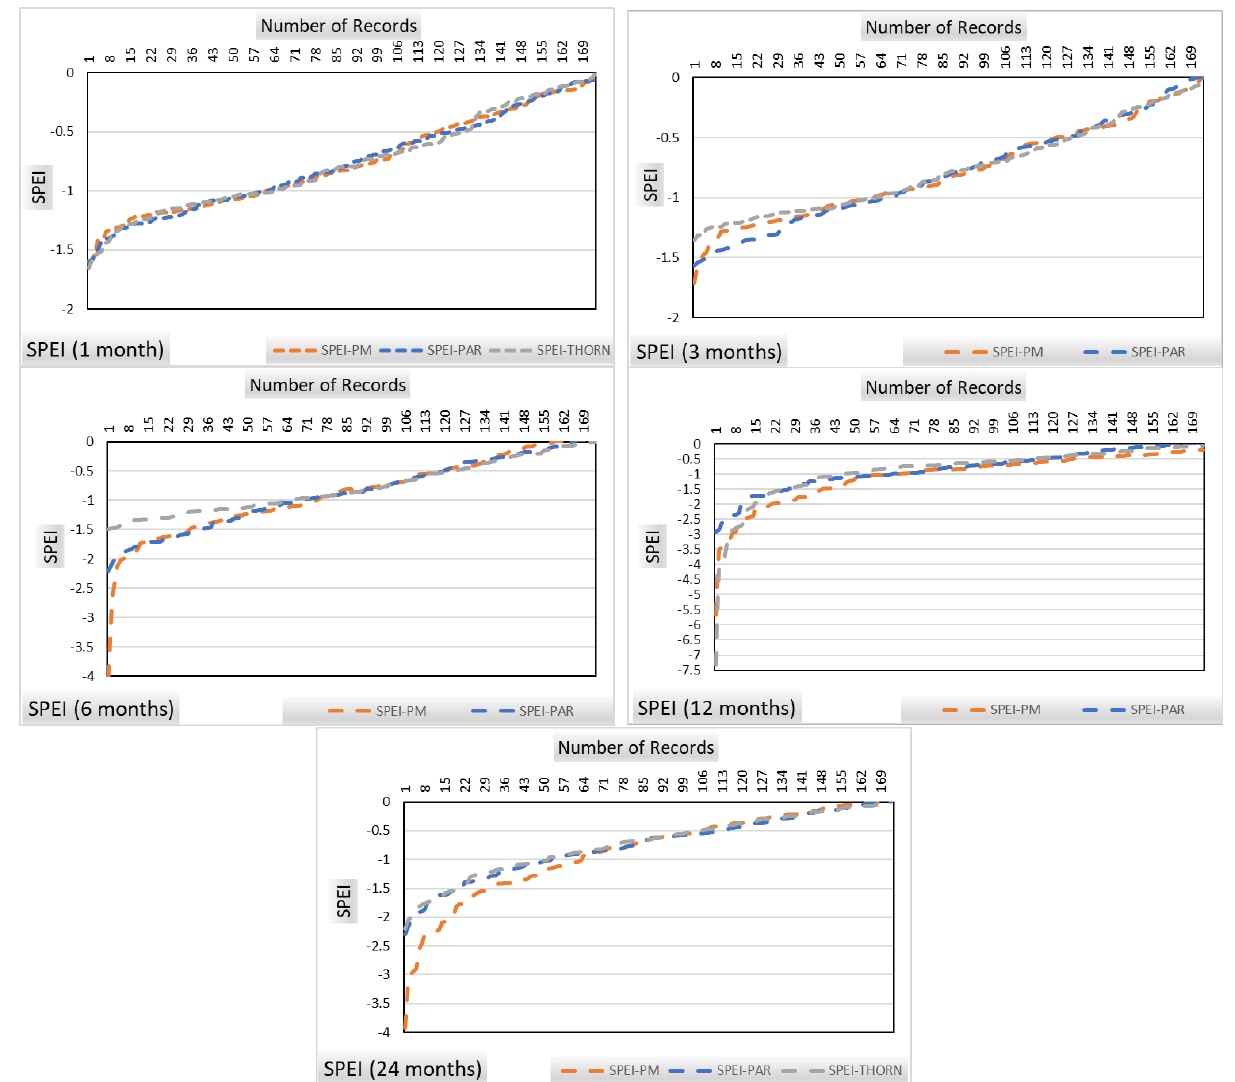
Figure 3. SPEI drought empirical plots (Davis station.